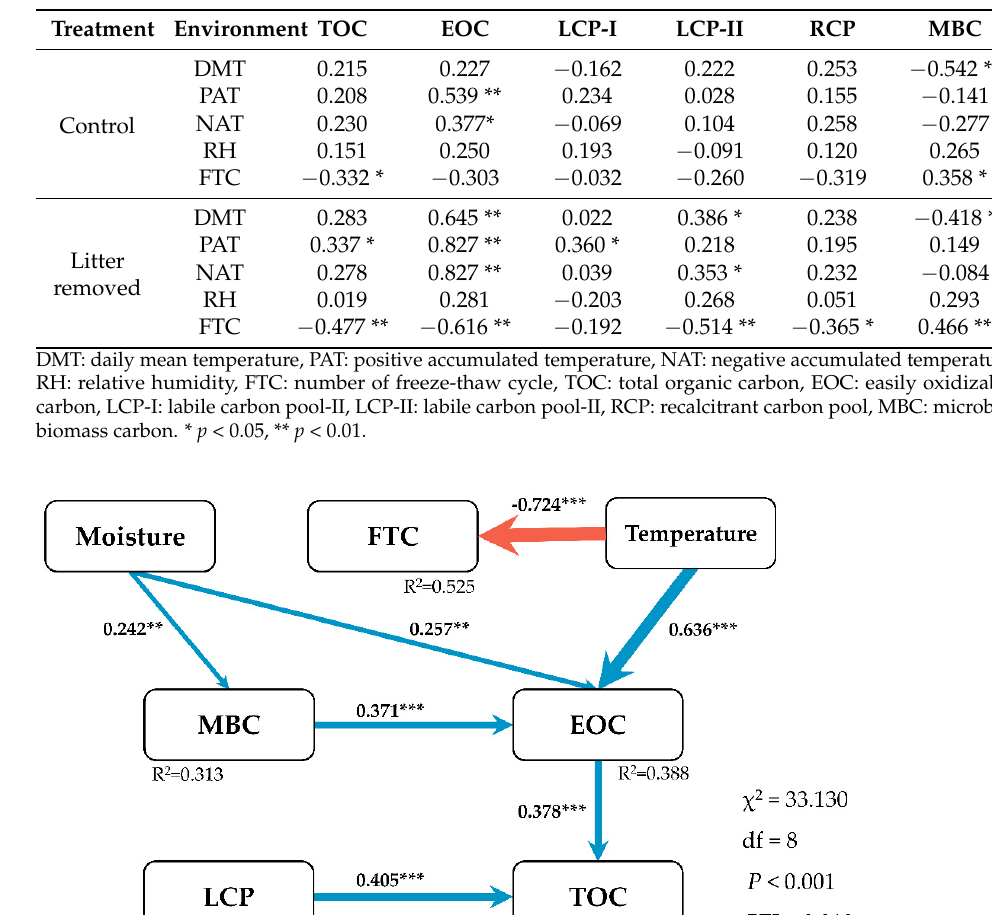
Table 5. Results of correlation analysis between the soil organic carbon fractions and environmental factors with different litter treatments.